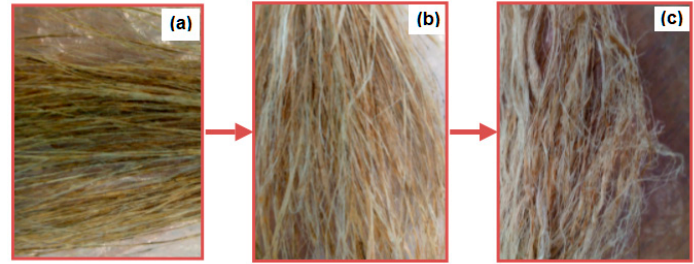
Figure 4. Images of ( a ) under-, ( b ) optimally, and ( c ) over-retted fibers.